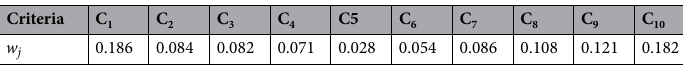
Table 10. Criteria weight.